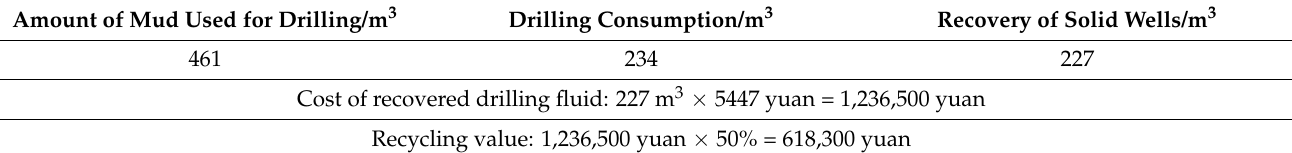
Table 7. Shale gas water-based drilling fluid recycling and